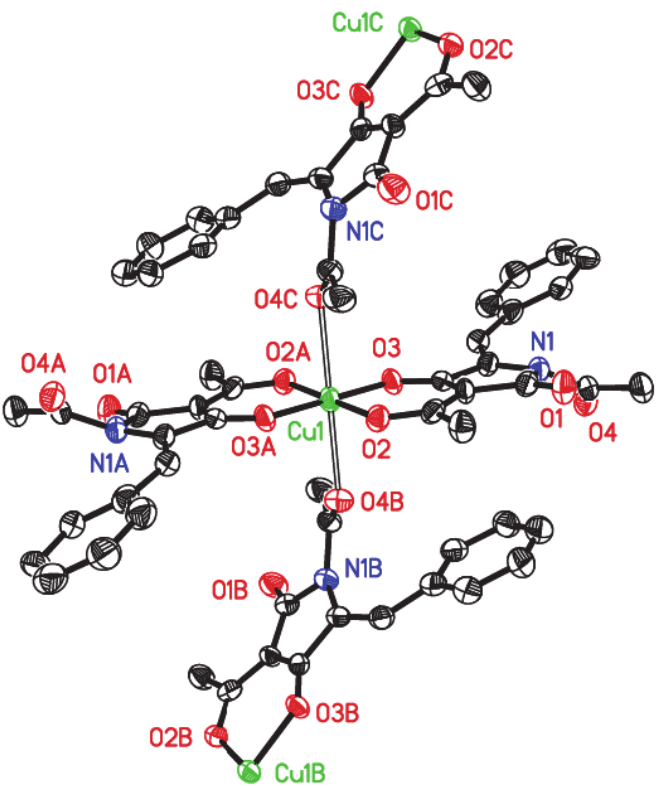
Figure 1: Perspective view of the complex showing 50% probability ellipsoids. Suffixes on the atom labels indicate atoms generated using the following symmetry operations: A, −𝑥 , 2 − 𝑦 , −𝑧 ; B, −𝑥 , 1/2 + 𝑦 , 1/2 − 𝑧 ; C, 𝑥 , 3/2 − 𝑦 , −1/2 + 𝑧 . Hydrogen atoms and the ethanol solvate molecule omitted for clarity.